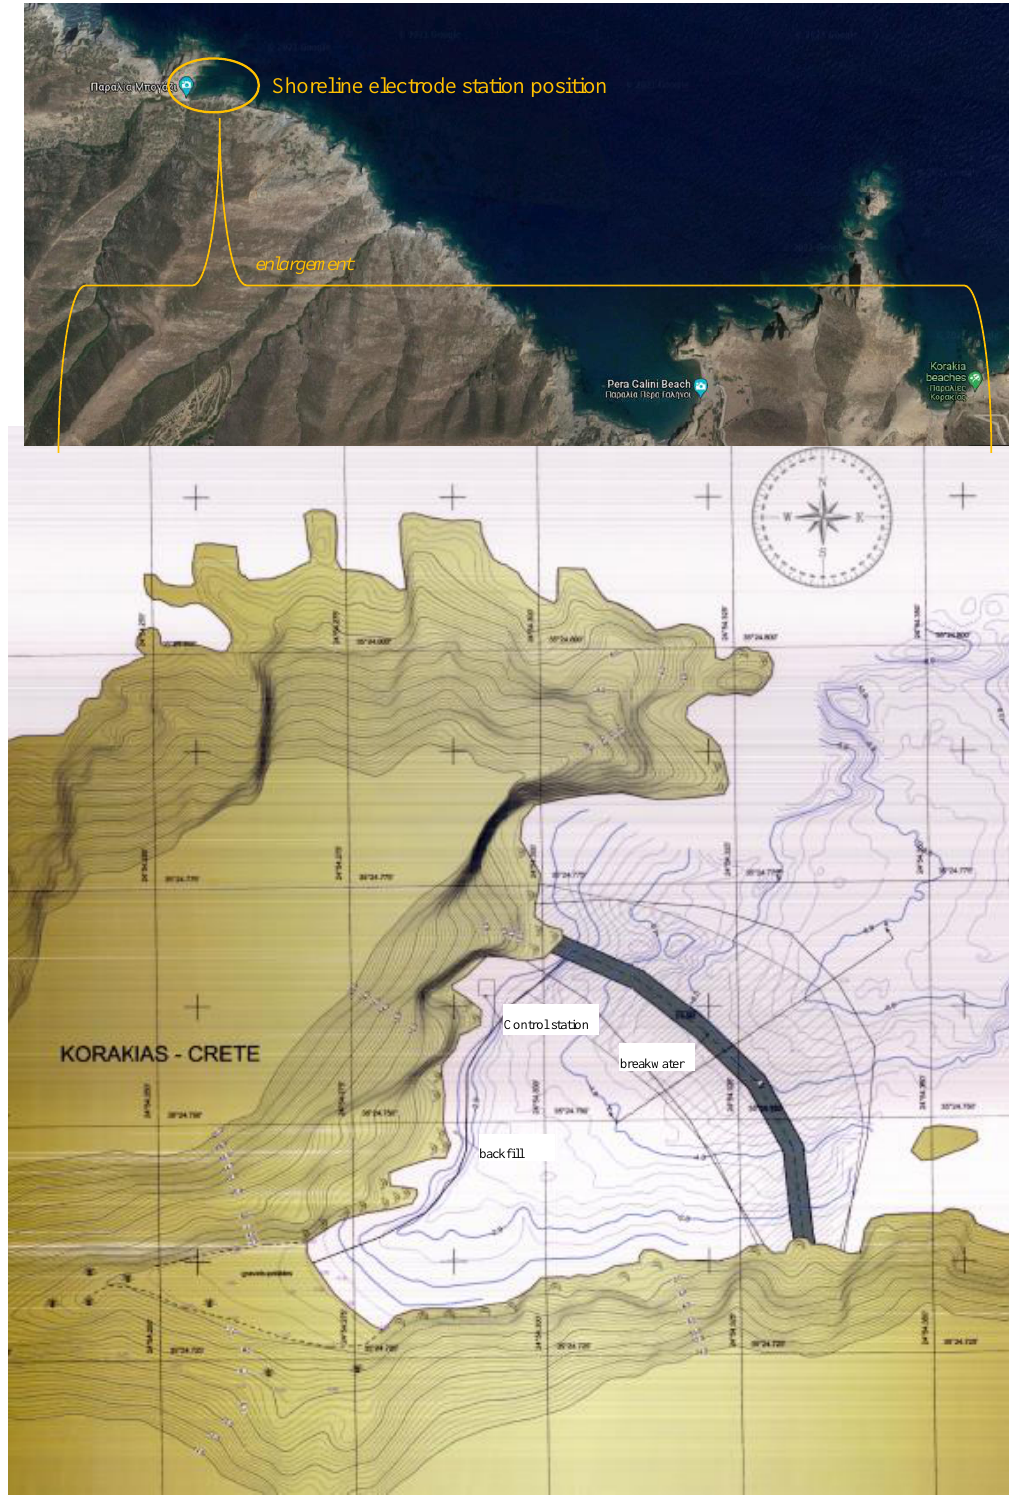
Figure 12. Shoreline electrode station at Korakia beach, Crete [79].